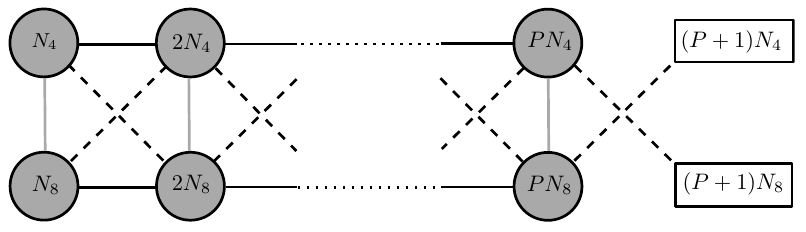
Figure 4 . Completed quiver with a (cid:12)nite number of gauge